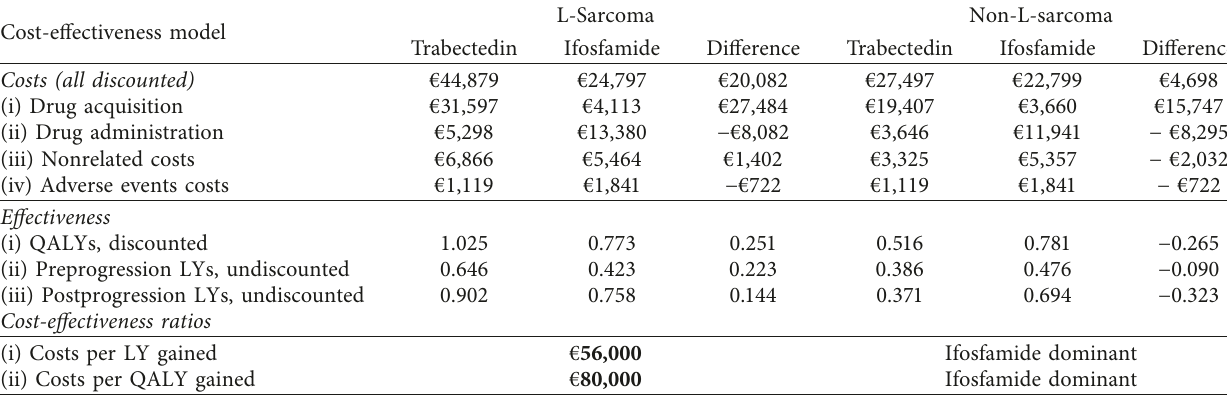
Table 7: Estimated average costs and effectiveness, comparing trabectedin and ifosfamide in advanced L-sarcoma and non-L-sarcoma. Cost-effectiveness